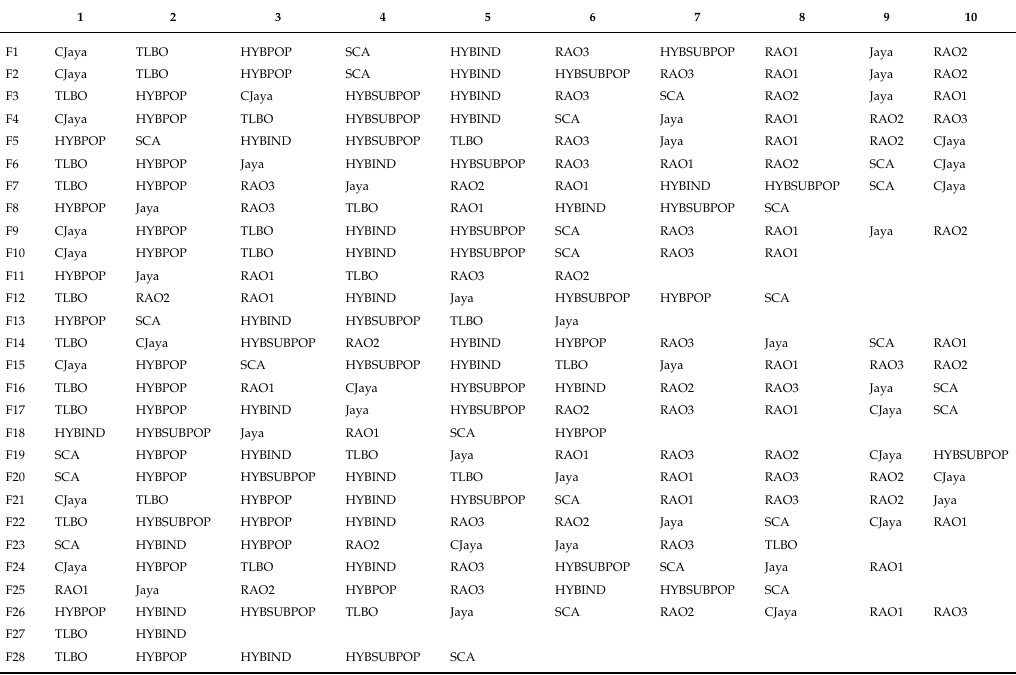
Figure 1. Convergence curves. The population size is set as 140 and the number of iterations to 1000. Table 6. Ranking of the algorithms according to the number of iterations required to achieve an error of less than 0.001. The population size is set as